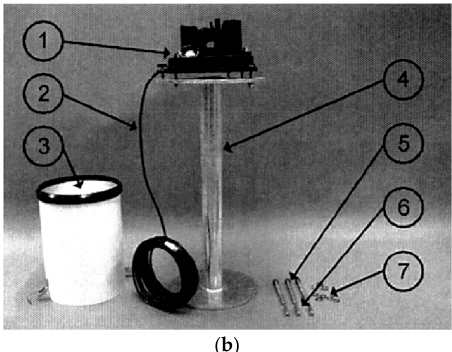
Figure 2. ( a ) Lefkosa rain gauge station; ( b ) Rain gauge with the installation equipment. The following numbers refer to the installation equipment of rain gauge (see Figure 2 ( b )): 1 = Sensor base; 2 = Sensor cable; 3 = Outer tube; 4 = Stand; 5 = Mounting bolts for the stand; 6 = Wedge bolts; 7 = Nut and washers for mounting bolts.